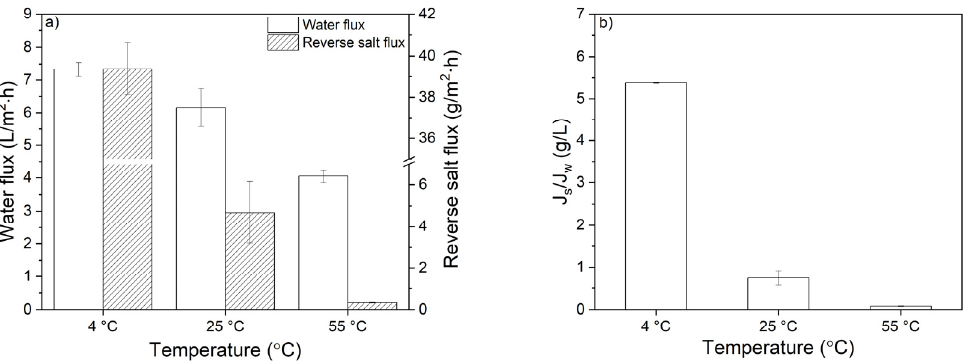
Figure 10. Effect of temperature on ( a ) water flux and reverse salt flux and ( b ) specific reverse salt flux (J s / J w ) of the membranes investigated. Dopamine concentration: 2.0 g / L. Feed solution: UPW. Draw solution: 1.2 M MgSO 4 . Co-current cross flow: 25 cm/s. Average values and standard deviations represent two replicate samples.